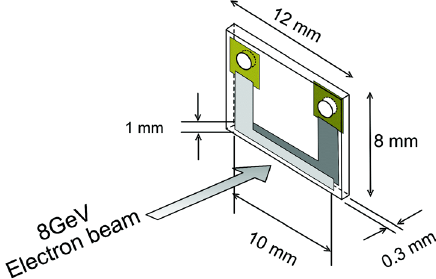
FIG. 14. Dimensions of newly designed diamond-based